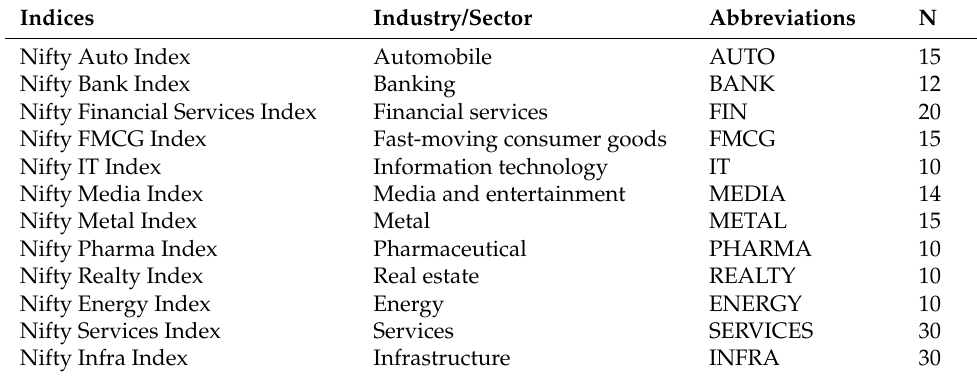
Table A1. Sectoral Indices of